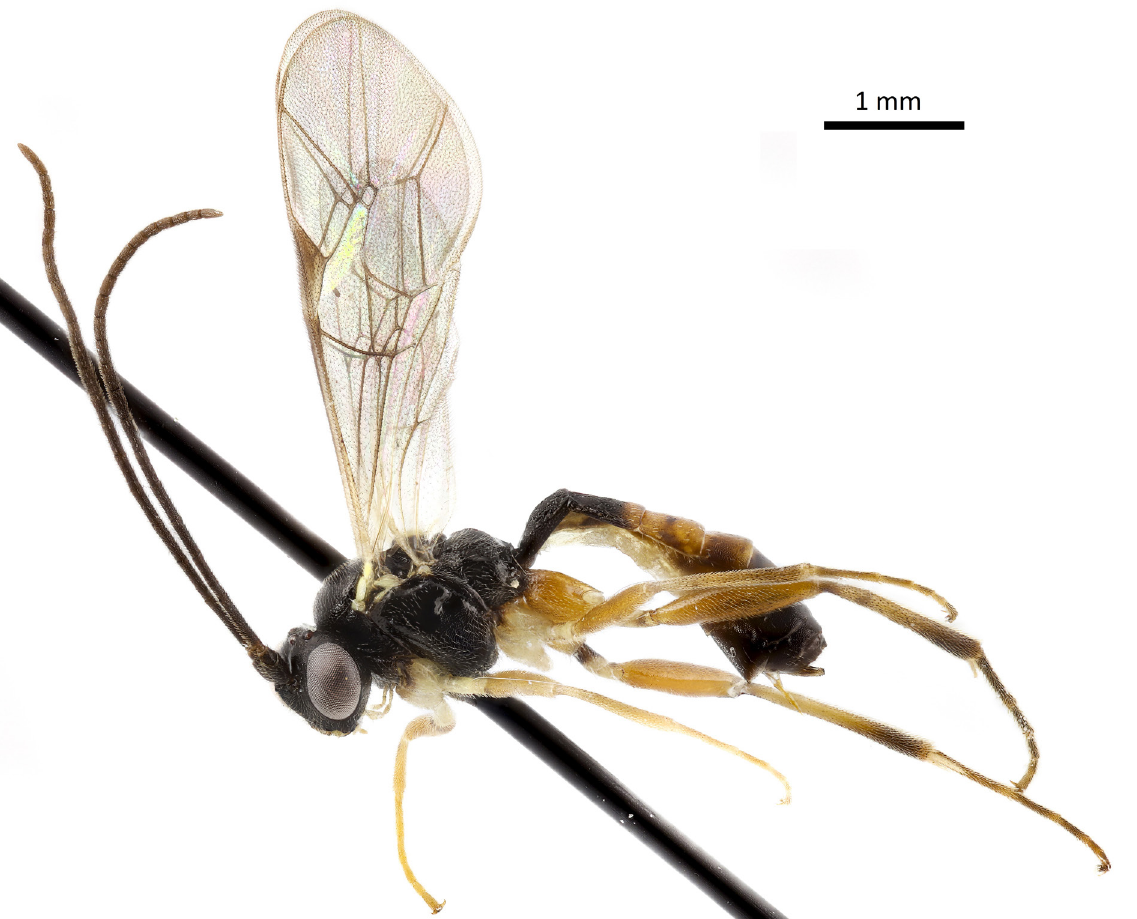
Fig. 6. Homotropus mugerwai sp. nov., paratype, ♀ (NHRS-HEVA000011633). Habitus, lateral